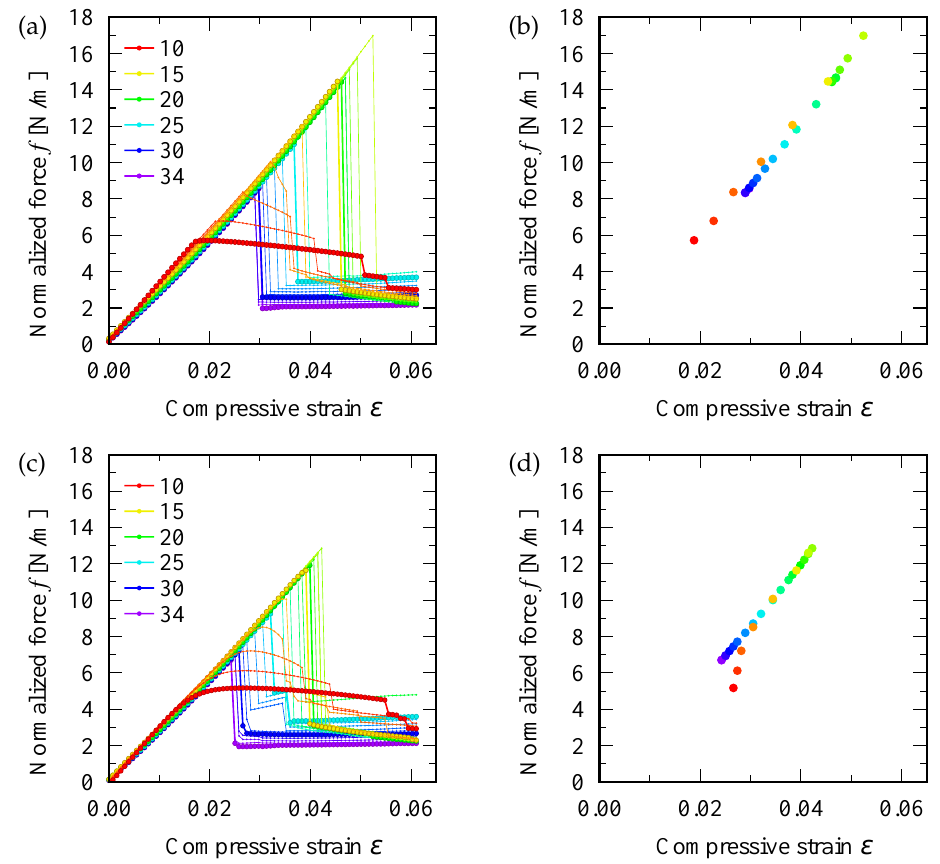
Figure 4. ( a , c ) Normalized force f ≡ F / ( π d ) (i.e., applied compressive force F divided by circum- ferential length π d ) as functions of the compressive strain ε . ( b , d ) Diagram of the critical buckling normalized force f c ≡ F c / ( π d ) and critical buckling strain ε c . The top (bottom) panels correspond to pristine (defective) SWNTs. The colors of data points and lines represent the chiral index n . Figure 4b,d depict the diagram of critical buckling normalized force f c and the cor- responding strain ε c for defect-free and defective SWNTs, respectively. Almost all data points were observed on a common straight line, except for a few left-bottom data points (colored in red and magenta) that correspond to the S-mode buckling. Comparisons of the two diagrams revealed that the insertion of an SW defect resulted in reduction in the maximum values of f c and ε c by approximately 19 and 24 %, respectively (represented by the data point located in the upper right corner in the